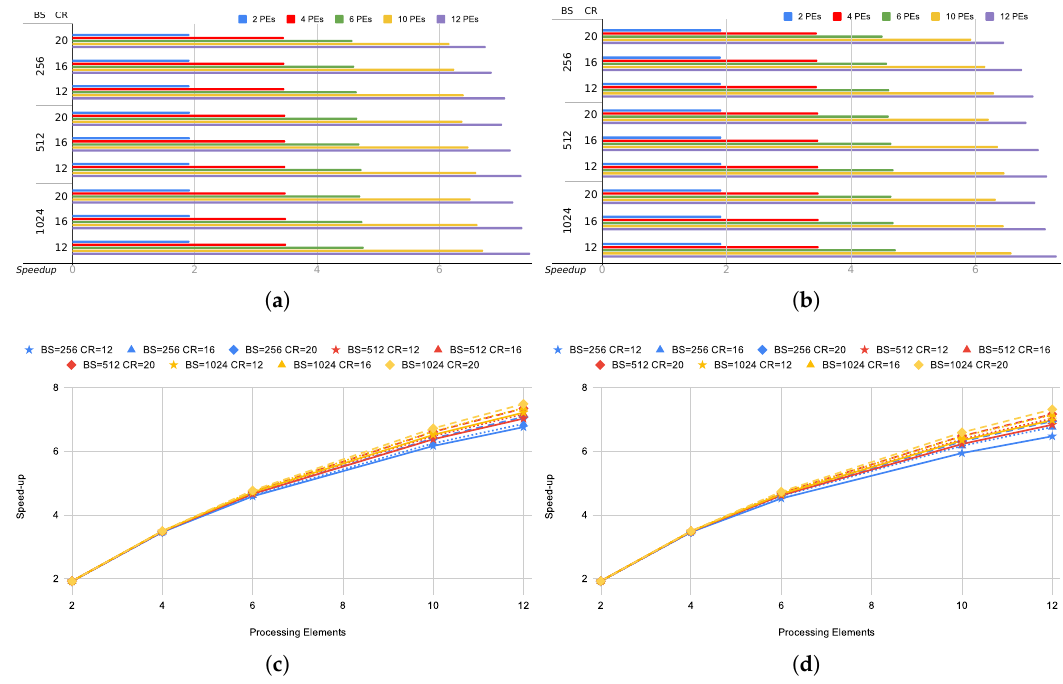
Figure 12. Speed-up obtained for multiple PEs compared to the 1 PE version of the HyperLCA HW compressor. ( a ) Speed-up N bits = 8; ( b ) Speed-up N bits = 12; ( c ) Speed-up curve N bits = 8; ( d ) Speed-up curve N bits =